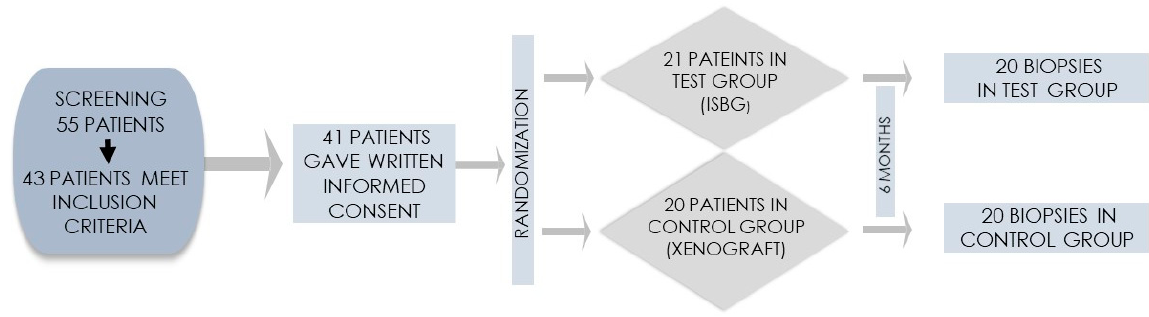
Figure 1. Flowchart of the randomization process.